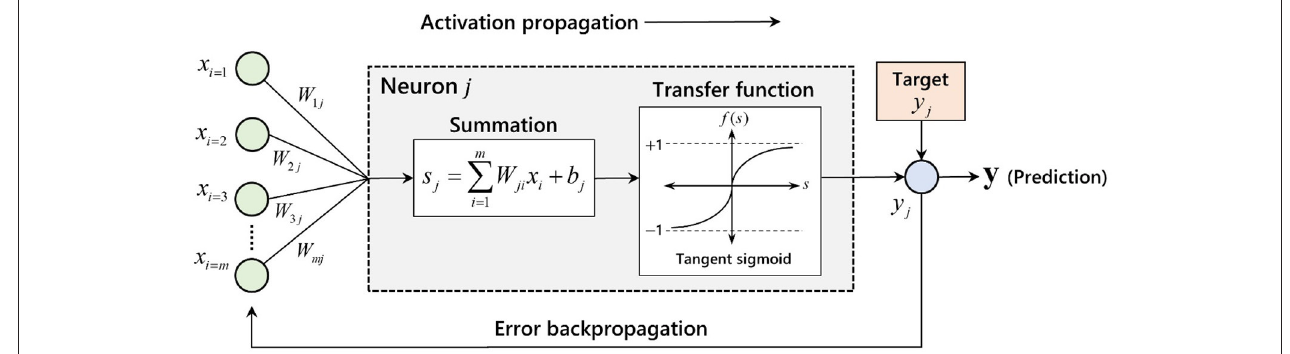
FIGURE 5 | Feedforward (or activation propagation) and error backpropagation phases for neuron j